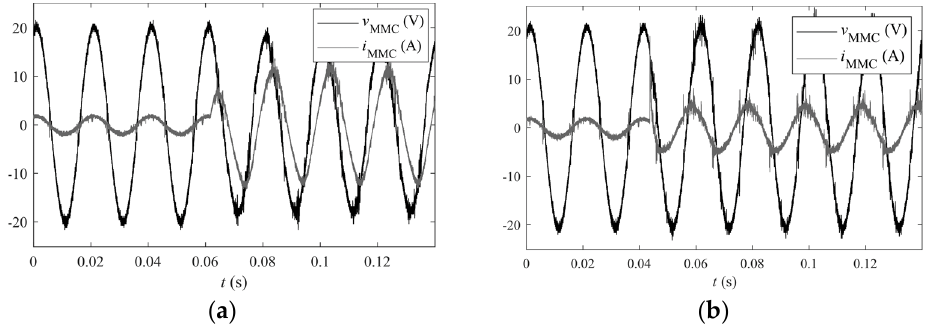
Figure 18. Step response from ( a ) R to RL and ( b ) R to RC.